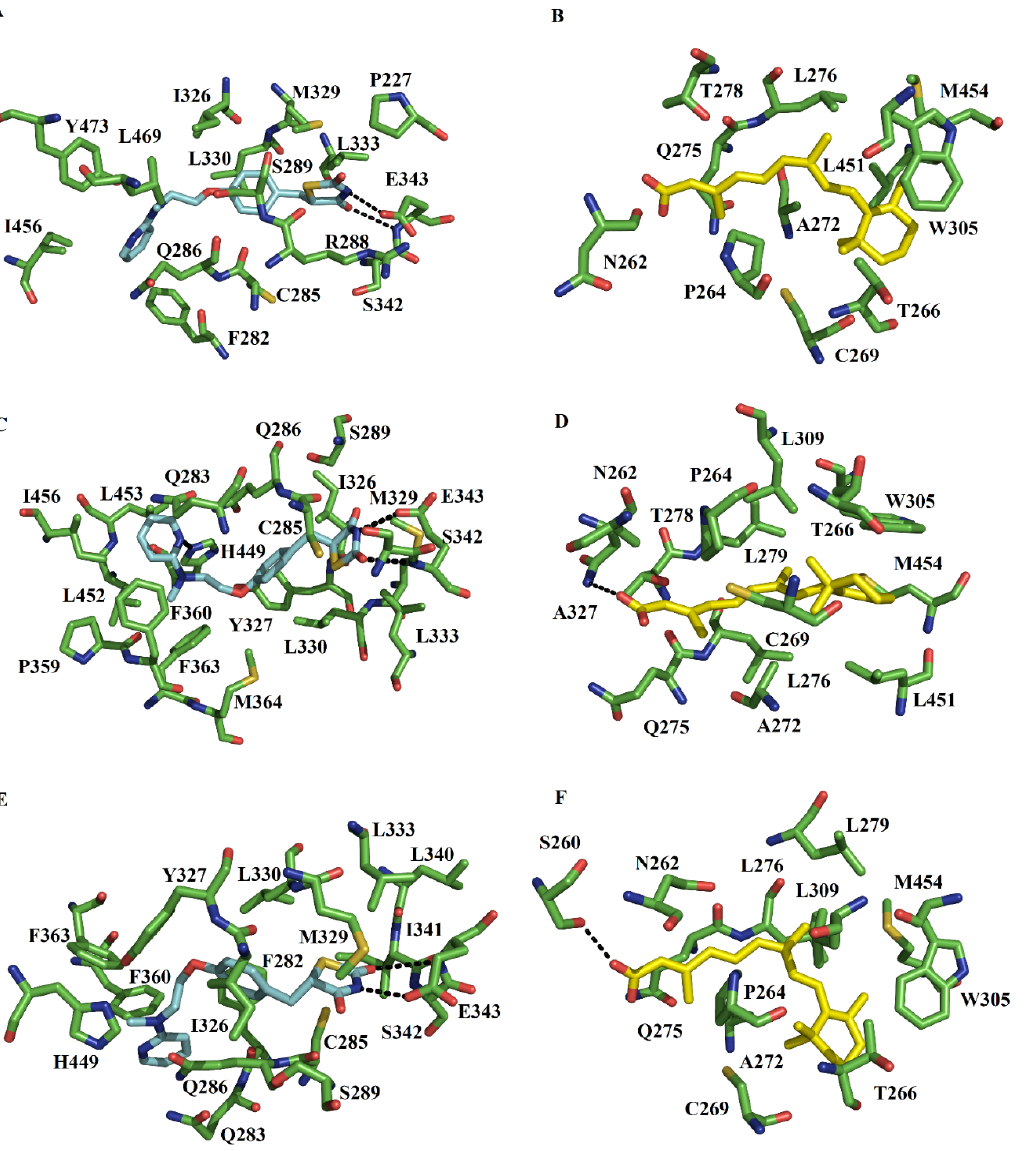
Figure 2. Protein-ligand interactions of RGZ and 9CR in the PPAR γ -RXR α -DNA system. Interactions with RGZ and 9CR at the ligand-binding site of PPAR γ and RXR α , respectively, are present in the first [RGZ ( A ) and 9CR ( B )], second [RGZ ( C ) and 9CR ( D )], and third [RGZ ( E ) and 9CR ( F )] most populated conformations. These structures are representative from the three major clusters. Arrows indicate HBs.